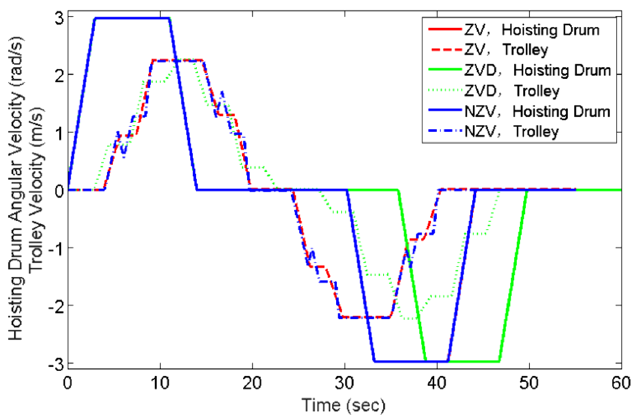
Fig. 4. Command angular velocity curves of the hoisting drum and the command velocity curves of the trolley under the different control methods.